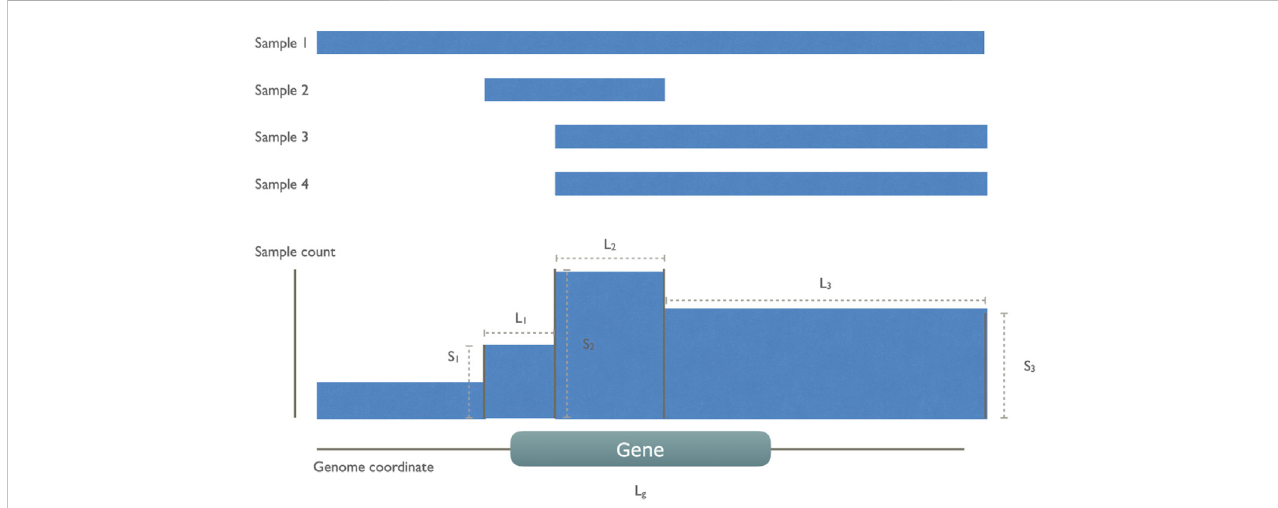
FIGURE 2 An illustration of gene score calculation The gene score was de fi ned to reward the high number of sample recurrence and penalize the length of segmentsandgenes.Inthisexample,therearefourcancersamples,allofwhichhave awholeorpartialdeletionontheindicatedgene g .TheseCNsegments are collapsed to a collective track, leaving four collective segments of which only three of them overlap with the gene. The gene score sums over these three segments ( i ) with count of involved sample S i divided by the sum of segment length L i and the common gene length L g